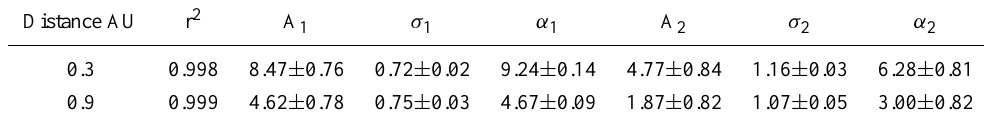
Table 3. Fast Wind: Values of the parameters obtained from the fit of the PDF relative to angular fluctuations. Distance AU r 2